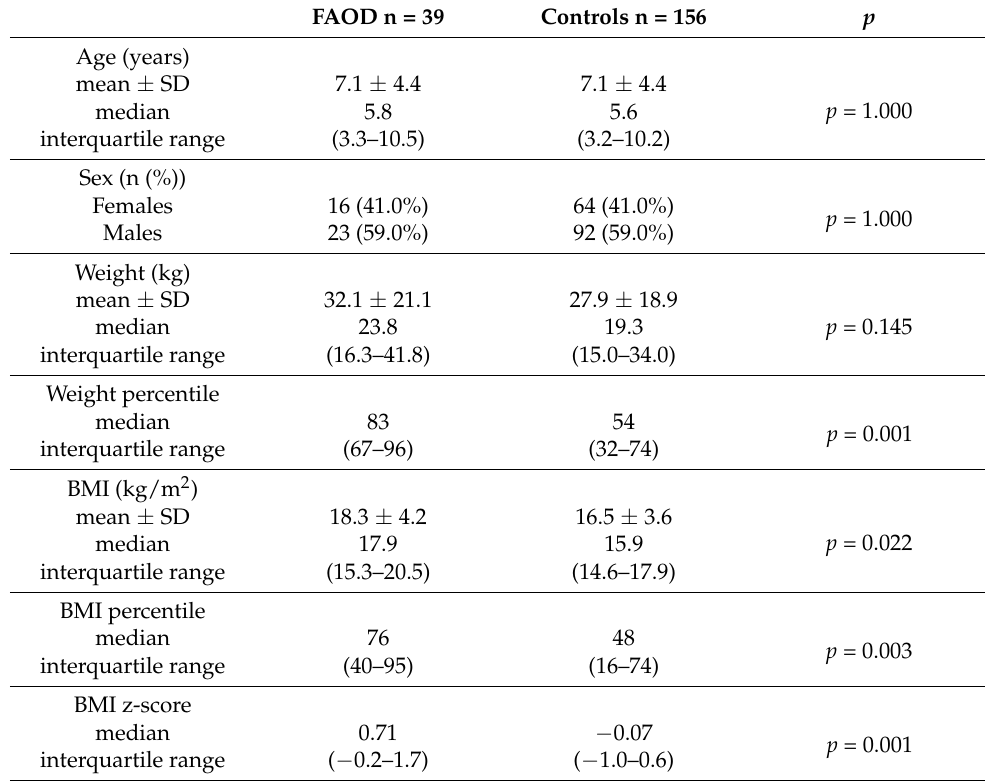
Table 1. Population